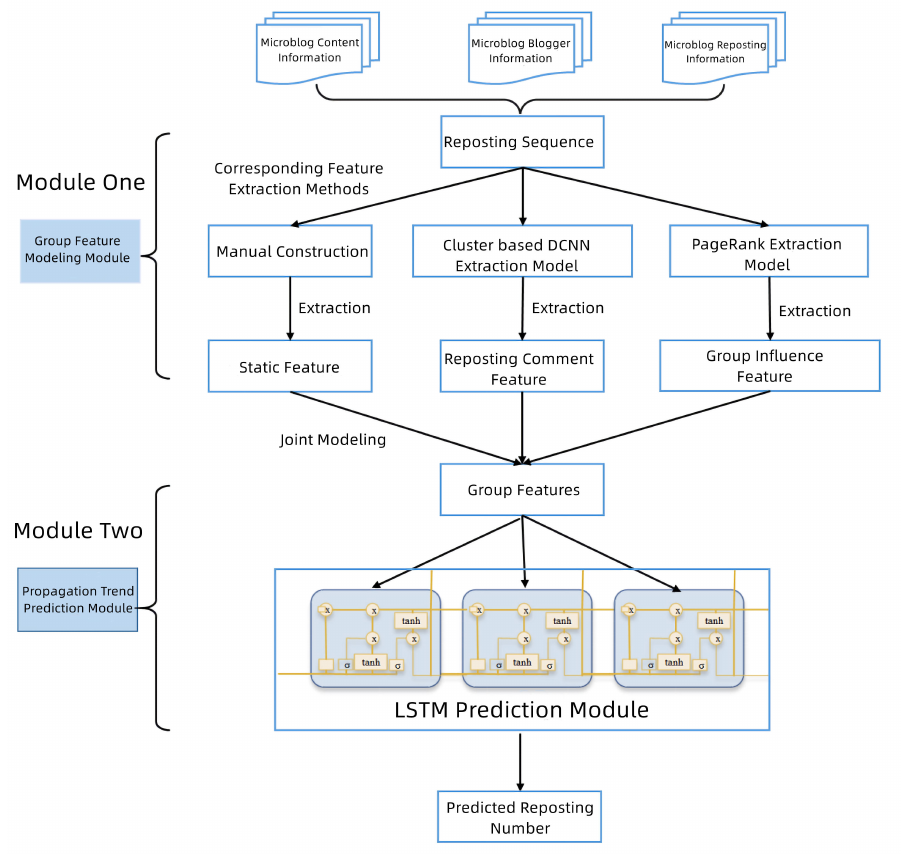
Figure 10. Time-dependent prediction process based on group